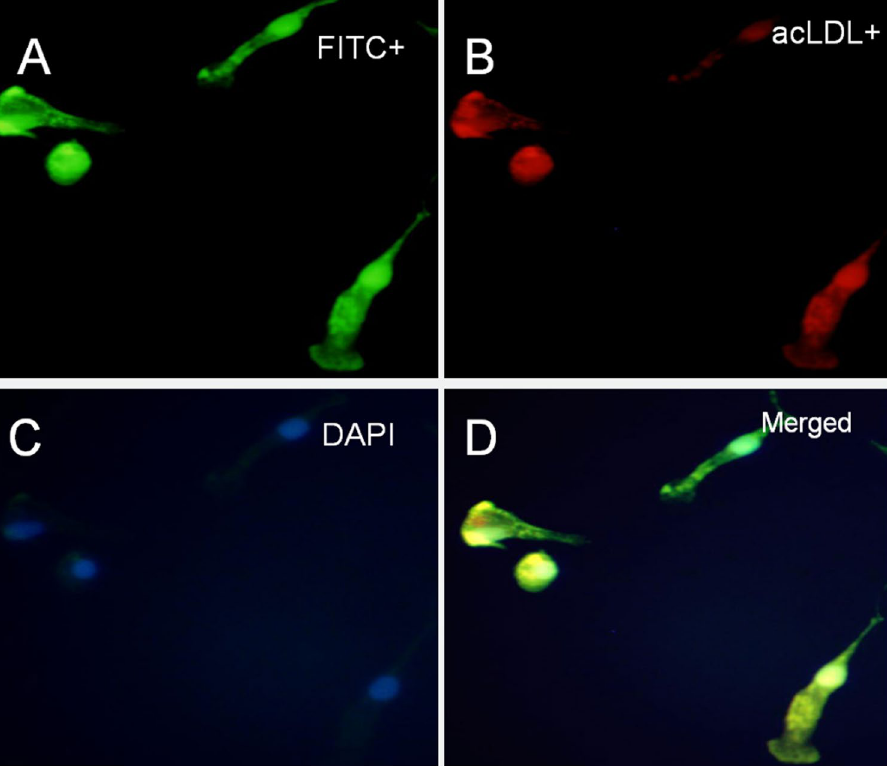
Figure 2. Identification of EPCs. After seven days of culture, EPCs were incubated with Dil-Ac-LDL and FITC- labeled lectin. Fixed cells showed the uptake of DiI-acetylated LDL and FITC-labeled lectin, and were double positive for DiI-Ac-LDL and